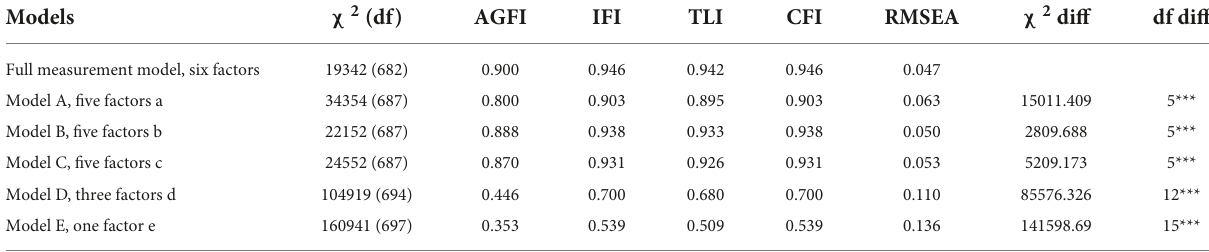
TABLE 3 Study 2–Measurement model